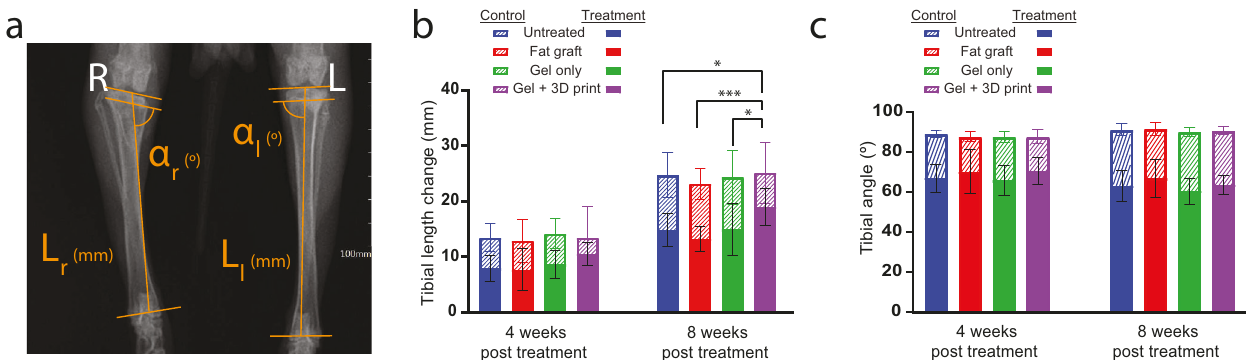
Fig. 7 3D printed growth plate mimetic composite promotes increased bone elongation. a Representative radiograph showing the method for measuring tibial length (L) and tibial angle ( α ). b Tibial length change for the control limbs (dashed) and treatment limbs (solid bars) at 4- and 8-weeks post treatment. While there was no difference in tibial length change amongst the control limbs, the gel + 3D print condition had signi fi cantly more tibial growth compared to other treatments. Data represent mean ± standard deviation (error bars). *Denotes signi fi cant difference in tibial length change of treatment limbs (* p < 0.05, *** p < 0.001; two-way ANOVA, Tukey ’ s HSD post hoc). c Tibial angle of control limbs (dashed) was similar, as were the tibial angles of the treatment limbs (solid bars) across groups. Data represent mean ± standard deviation (error